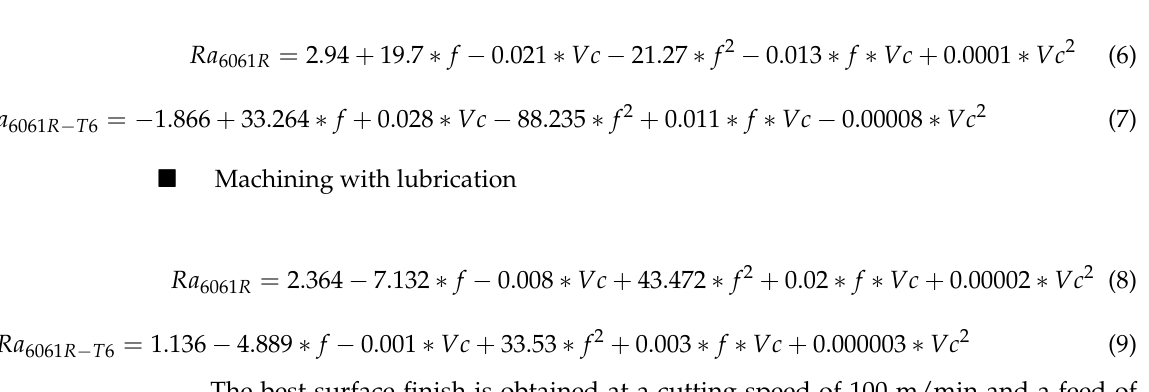
Table 7. Average values of surface roughness.